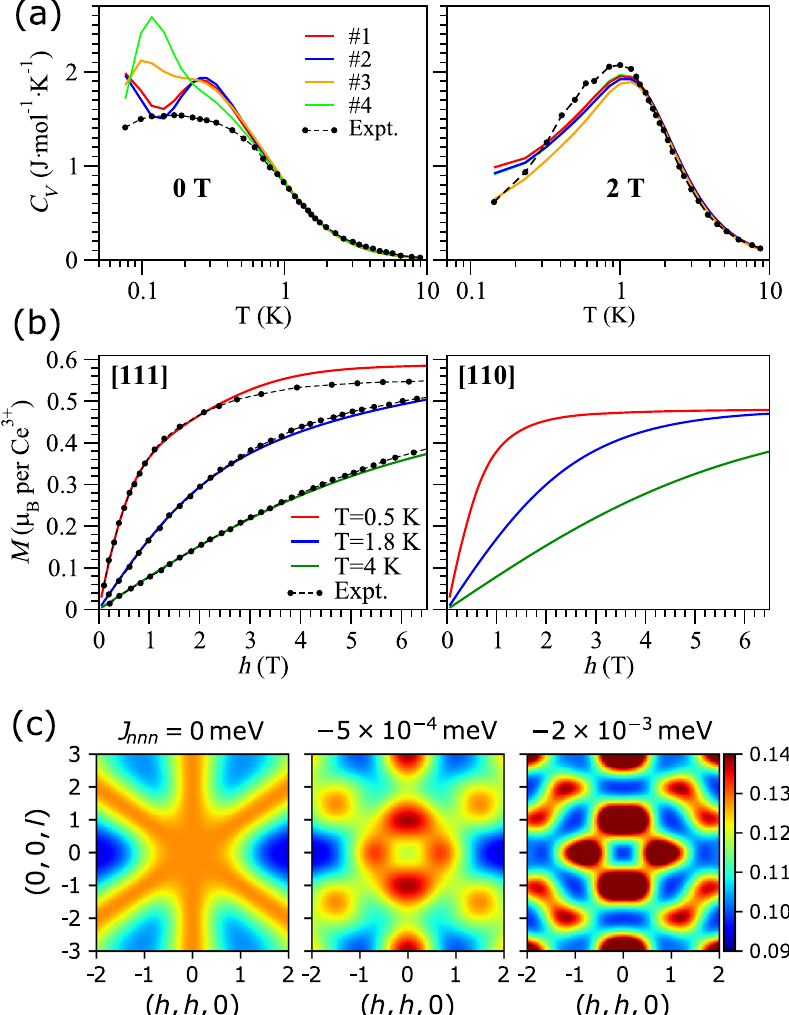
Fig. 2 Fitting magnetization, speci fi c heat, and neutron-scattering data to obtain the model Hamiltonian parameters. Results of a two- stage fi tting process used to determine the optimal Hamiltonian consistent with all reported experiments. a Speci fi c heat as a function of temperature obtained for four different model parameter sets, vs. experimental data (extracted from ref. 9 ) for the case of zero fi eld and applied fi eld of 2 T along the [111] direction. b Magnetization obtained from fi nite temperature Lanczos of the model Eq. (1) on a 16-site cluster (for analysis of fi nite-size effects, see Supplementary Note 4) as functions of magnetic fi eld applied along the [111] and [110] directions. For clarity, the theoretical data is shown for one parameter set only (set no. 2, see Methods and Supplementary Note 3, also for fi ts with other parameter sets, of comparable quality) and only the experimental results for magnetization (extracted from ref. 9 ) with fi eld along [111] direction have been shown. c The predicted zero- fi eld neutron-scattering structure factor S ( q ), Eq. (4), computed with SCGA, for three different values of J nnn , with the left panel ( J nnn = 0) corresponding to the nearest-neighbor only model, Eq.